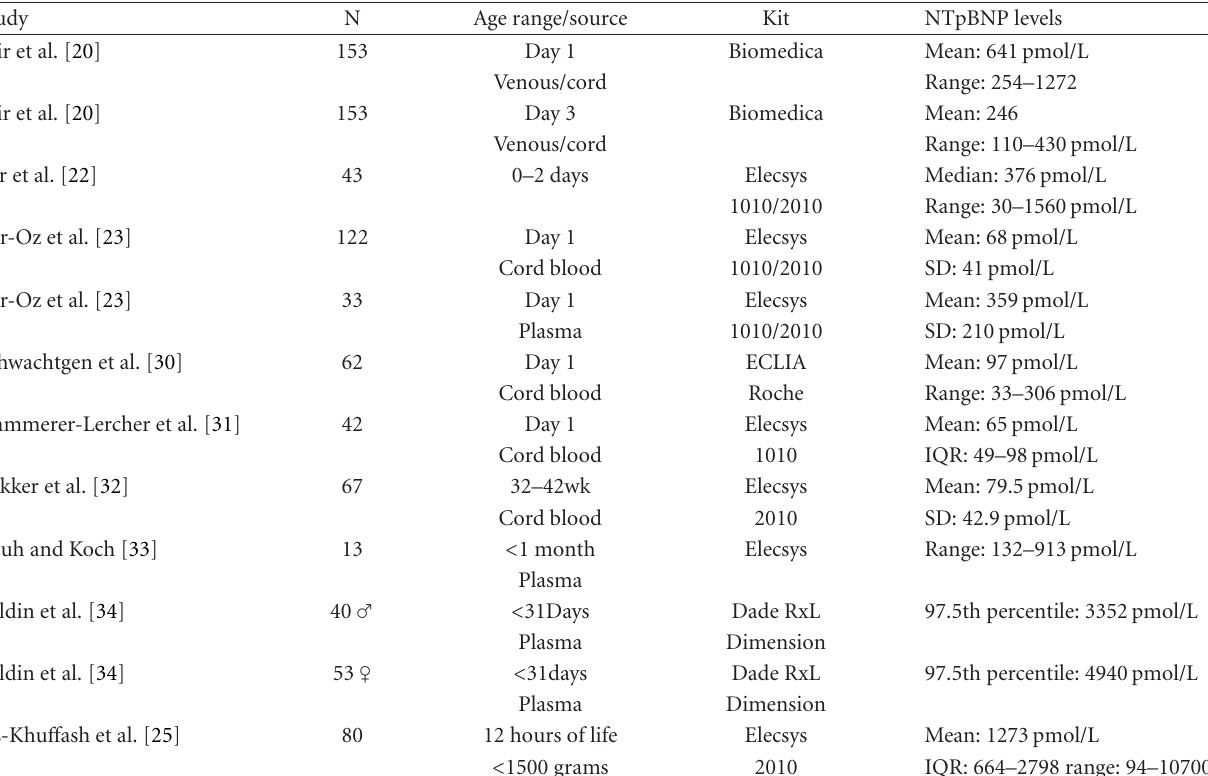
Table 1: Reference ranges for NTpBNP.